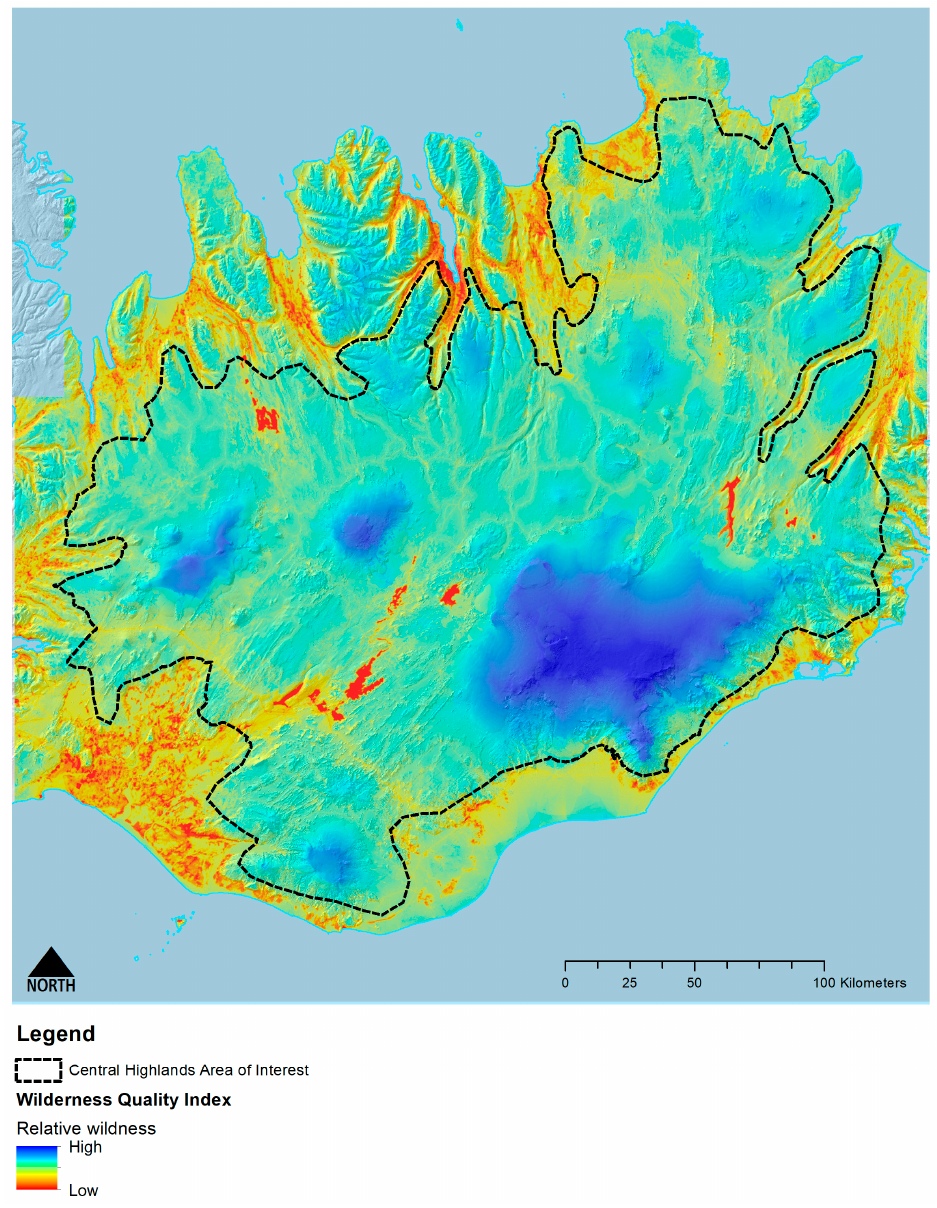
Figure 6. Wilderness Quality Index (WQI) for the Central Highlands .